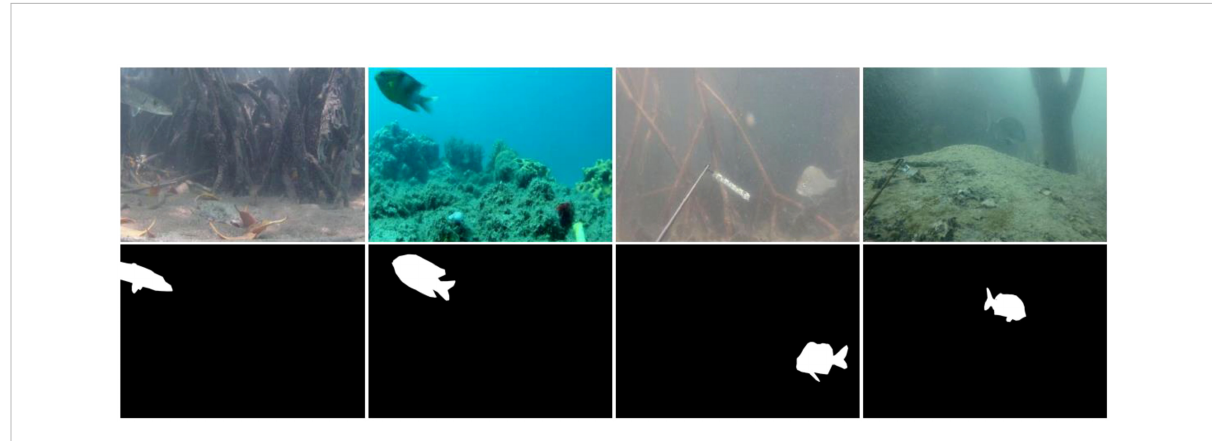
FIGURE 5 DeepFish (FishSeg) sample images with corresponding ground truth images. (The white pixels in the ground truth images belong to fi